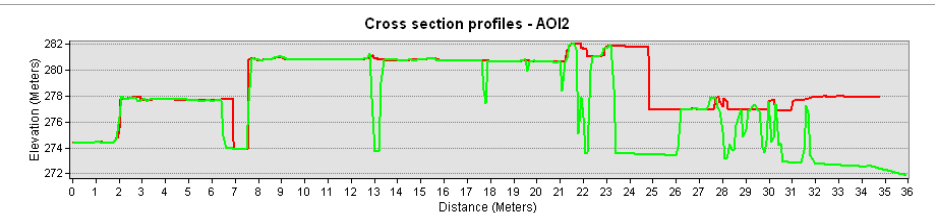
Figure 9. Vertical cross section of DSM obtained from photogrammetric software shown in Red and from Enhanced DSM obtained from research methodology shown in Green for the AOI2